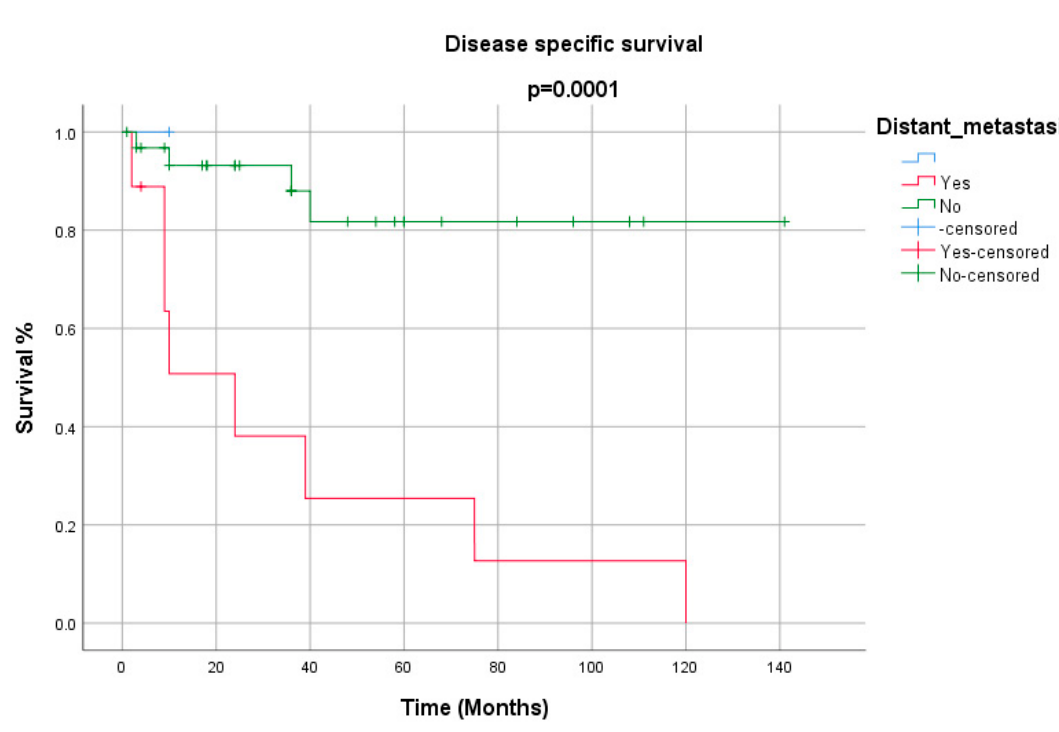
Figure 5. Disease-specific survival for distant metastasis.